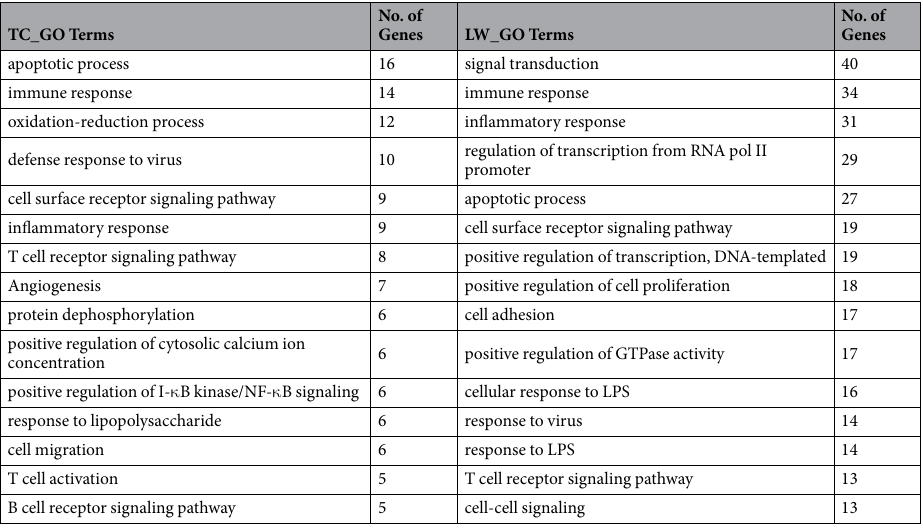
Table 2. The top 10 GO biological process terms for targets of all down-regulated miRNAs in TC and LW